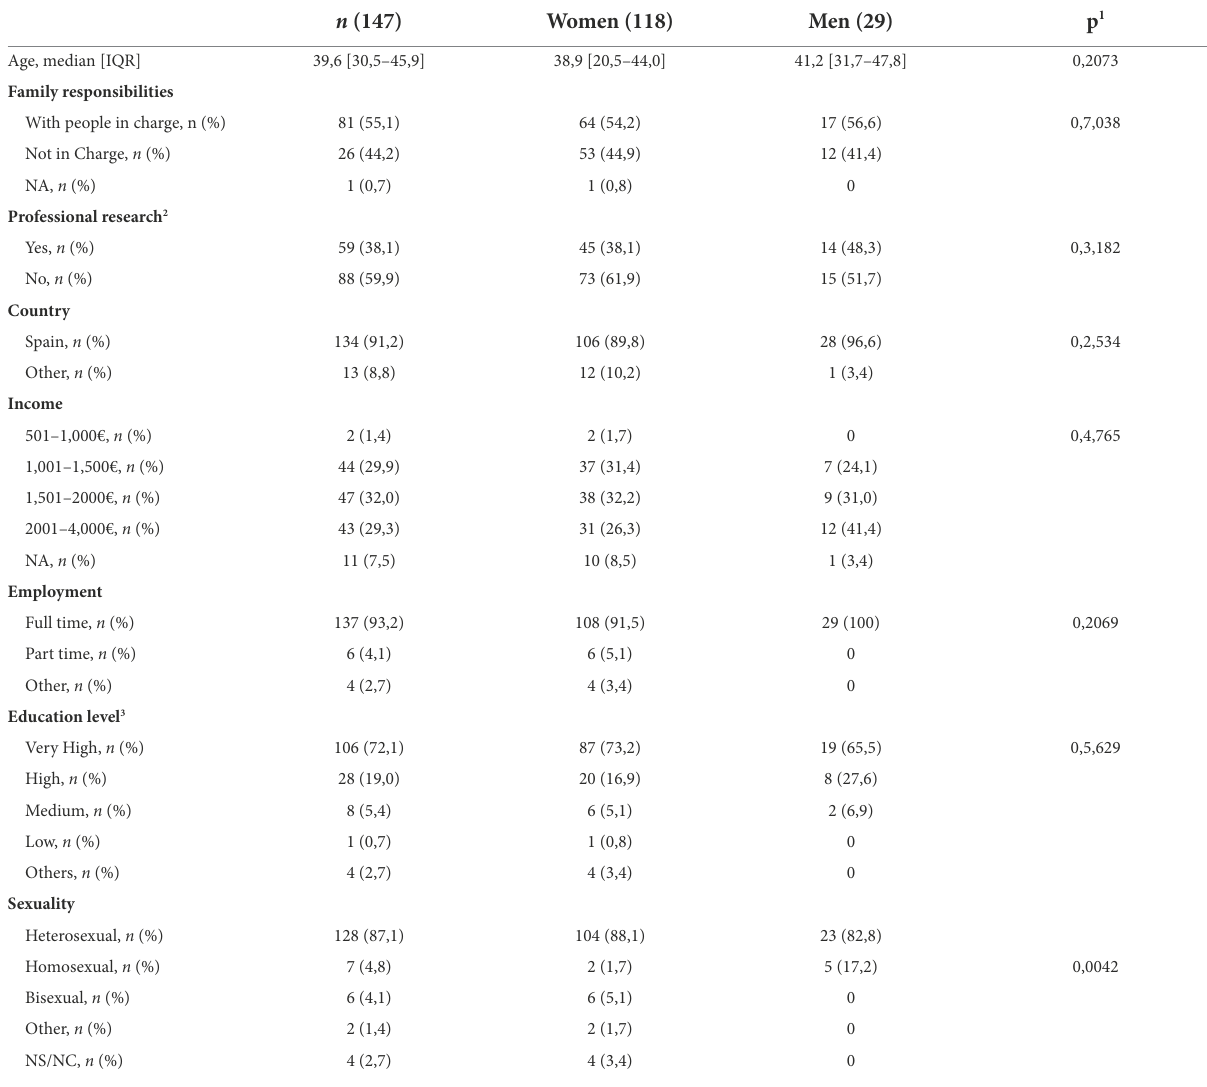
TABLE 1 Demographic characteristics of the scientists that respond to the